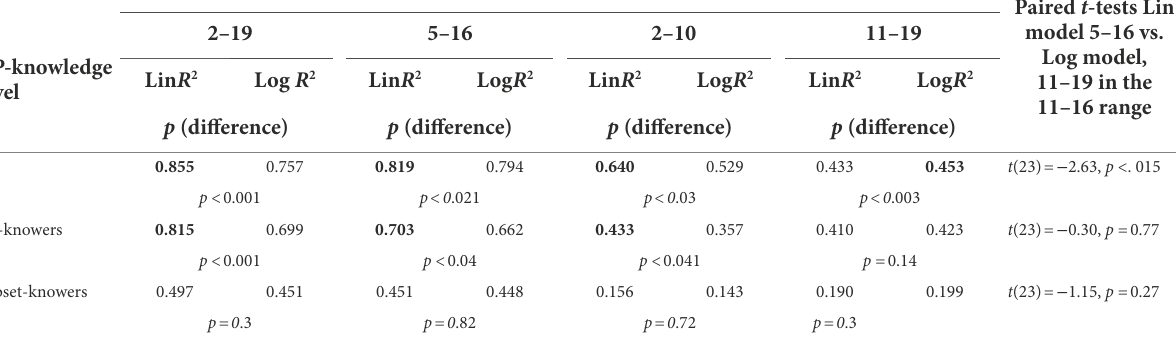
TABLE 1 Linear and log model fit ( p for differences determined by paired t -test) in the whole range (2–19), the single-middle-segment range 5–16 and separate ranges 2–10 and 11–19, and comparison of the linear model in the range 5–16 with the log model in the range 11–16 for the entire sample and individual CP-knowledge levels. Model by range Paired t -tests Lin model 5–16